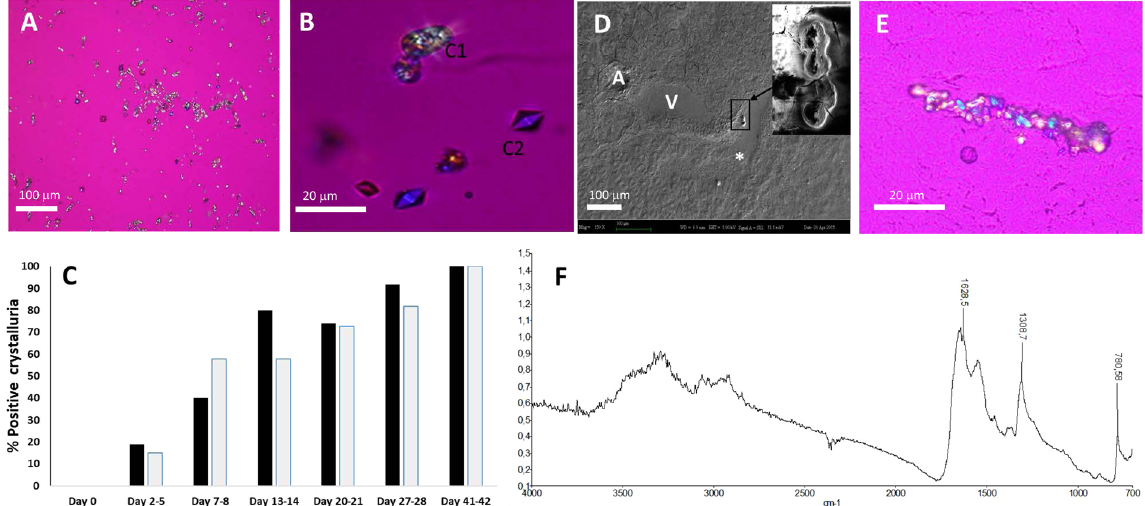
Figure 2. ( A , B ) Crystals in urines with COM (C1) and COD (C2) crystals observed at day 15 in HLP group with 2 different magnifications. ( C ) Quantification of positive crystalluria (expressed as a percentage) in HLP and HLP + FGF7 groups during the study (black and grey bars respectively). ( D ) COM crystals in one renal specialized fornix on day 15 detected by SEM analysis. ( E ) COM crystals located in one renal specialized fornix on day 42 detected by polarizing microscope. ( F ) Infrared spectrum of a crystal deposit detected in a specialized fornix, observed by reflection (infrared imager: Spotlight 400 FT-IR imaging system from Perkin Elmer) with a specific COM signature (peaks at 1308 and 780 cm − 1 ). Original magnification: (A) X40, (B and E) X400. A = artery. V = vein.